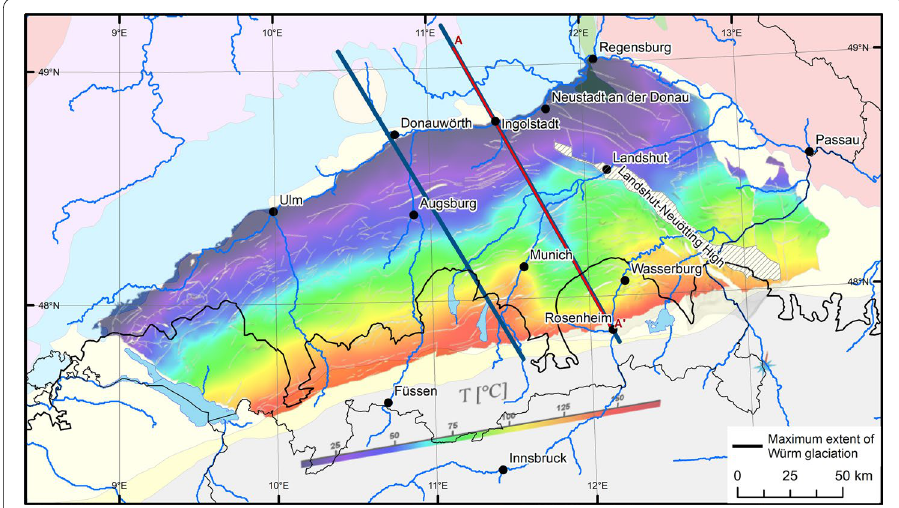
Fig. 2 Temperature at top Malm (Upper Jurassic) derived from the geostatistical 3D temperature model of the LIAG (Agemar et al. 2012; Agemar and Tribbensee 2018) and projected on the simplified geological map (Fig. 1). Maximum extent of the Würm Glaciation according to digital maps by Gibbard et al. (2011). Red line AA’ indicates the studied cross section. Dark blue lines (the eastern one being partially covered by red line AA’) indicate the locations of the GeotIS sections presented in Fig.